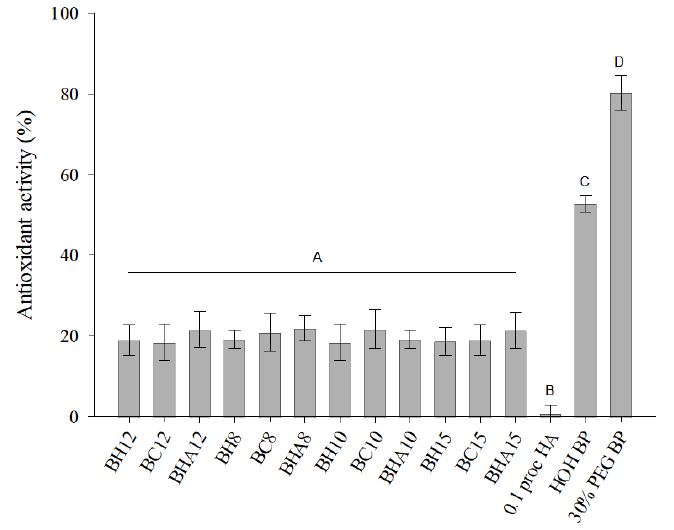
Figure 2. Antioxidant activity of prepared formulations, 0.1% Hyaluronic acid solution, aqueous and aqueous 30% PEG400 extracts of balsamic poplar buds by ABTS method. Different letters indicate statistically significant differences between the antioxidant activity of the samples ( p < 0.05). The antioxidant activity of an aqueous 30% PEG400 balsam poplar buds extract was evaluated by the post-column method using the ABTS reagent. It can be seen in the results that caffeic acid, p -coumaric acid, cinnamic acid and galangin showed antioxidant activity in the extract (Figure 3). Figure 3. HPLC chromatogram of 30% aqueous PEG400 balsam poplar buds extract combined with their respective post-column ABTS chromatogram which presented as negative peaks (1 — caffeic acid, 2 — p -coumaric acid, 3 — cinnamic acid, 4 — galangin).